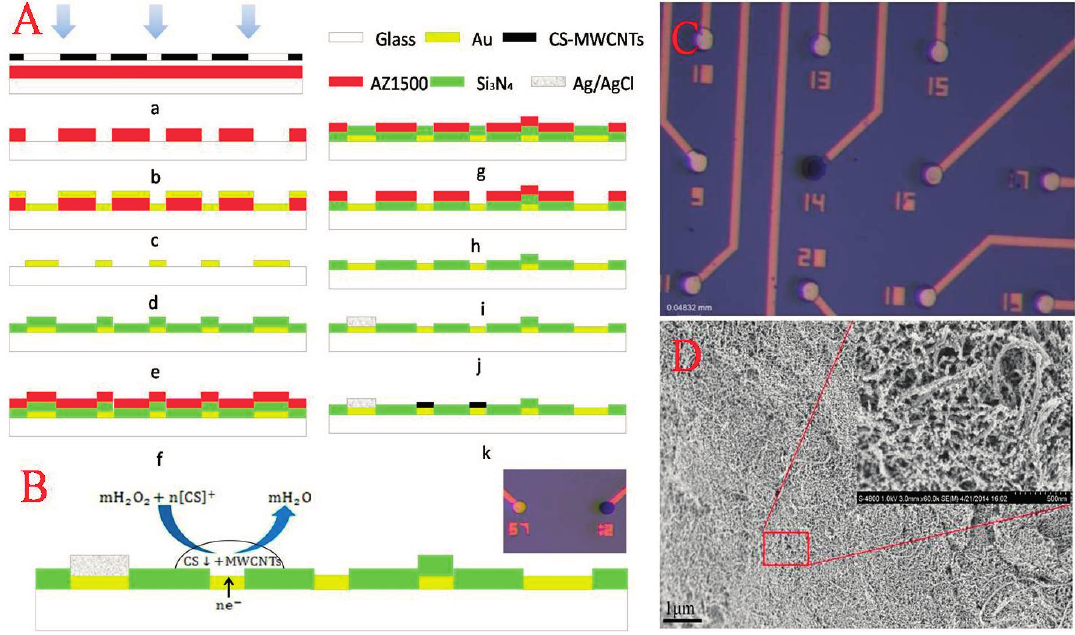
Figure 1. Fabrication and modification of the microelectrode array. ( A )